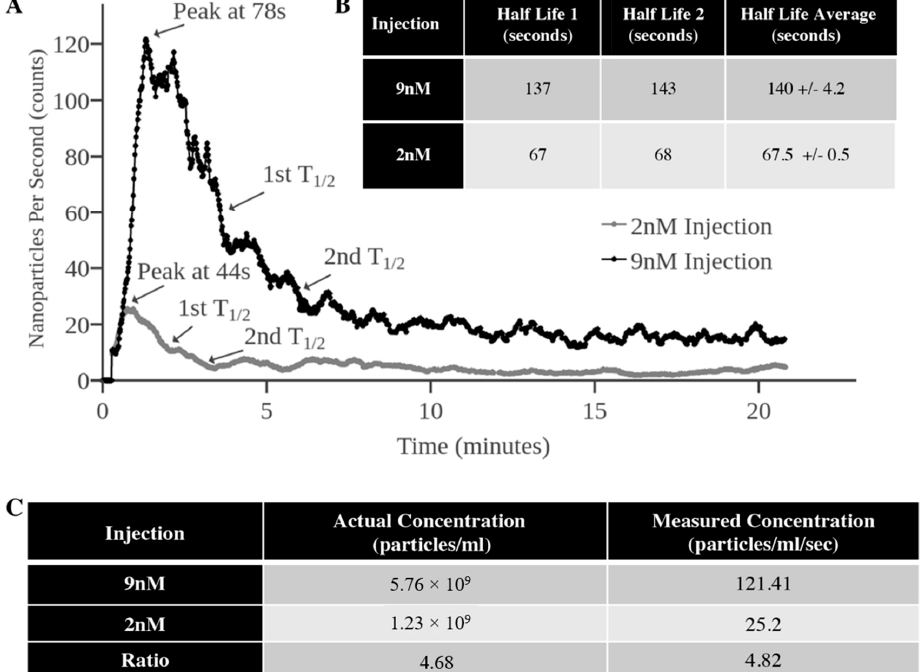
Figure 5. Blood concentration data derived from collective nanoparticle tracking within vasculature. ( A ) Nanoparticle blood concentration curves derived from two di ff erent nanoparticle